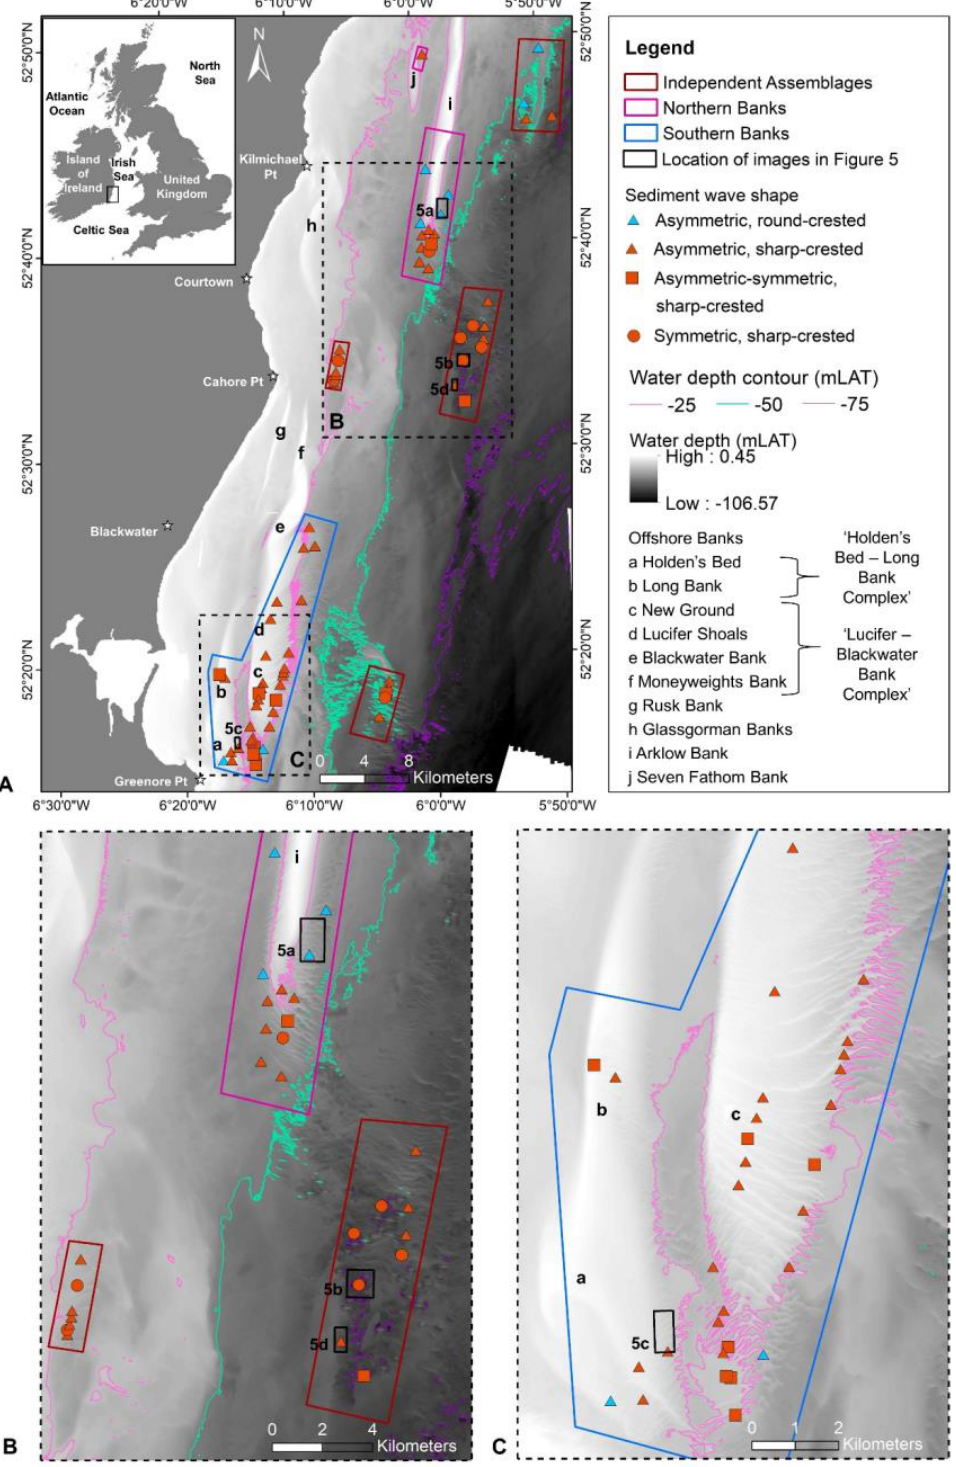
Figure 4. Interpreted average sediment wave shape across the south-western Irish Sea. The location of ( B , C ) are provided in ( A ). Black boxes and labels indicate the location of figures in Figure 5. Bathymetry source: composite map produced from INFOMAR datasets (https://www.infomar.ie/ data [Accessed: 10 June 2021]) (see Section